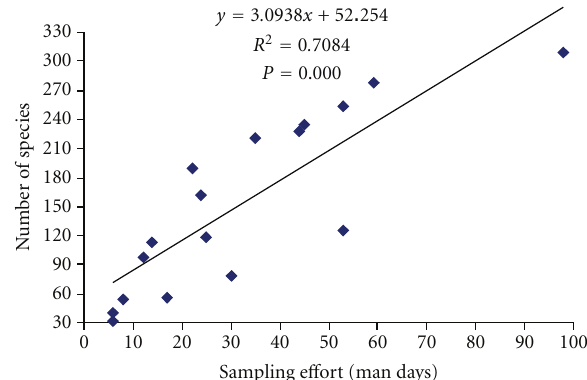
Figure 3: Sampling e ff ort and number of species.